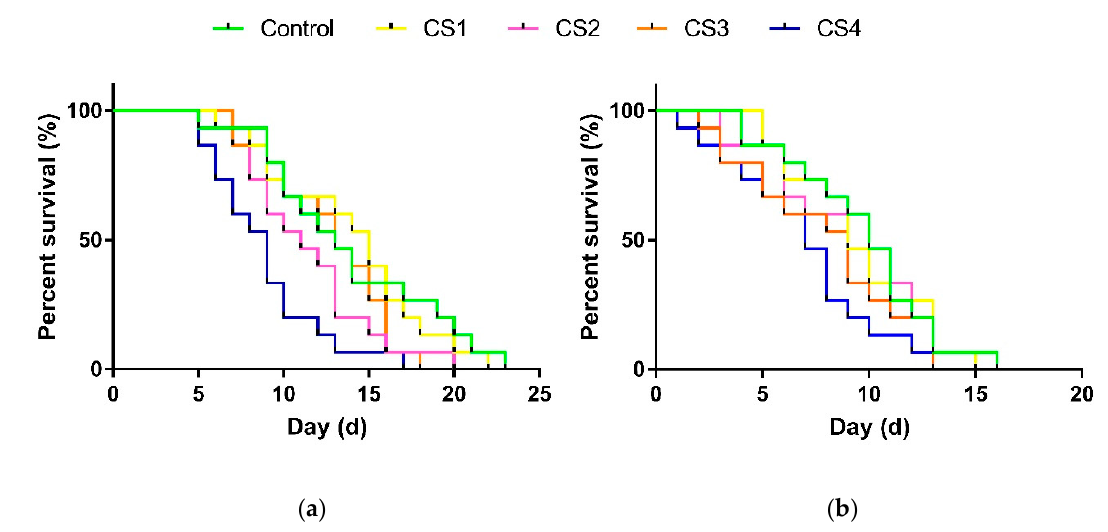
Figure 2. Survival curves of P. incisi post-storage female ( a ) and male ( b ) that had been subjected to different pupal cold storage treatments. CS1: cold storage 1, late-age pupae stored at 13 °C for 10 d; CS2: cold storage 2, middle-age pupae stored at 13 °C for 10 d; CS3: cold storage 3, late-age late pupae stored at 13 °C for 15 d; CS4: cold storage 4, middle-age pupae stored at 13 °C for 15 d. Control means P. incisi pupae developed at 25 °C ( n = 15). Table 4. Reproductive parameters of G1 P. incisi post-storage adults ( n = 15). Treatment Pre-Oviposition Period (d) Oviposition Period (d) Post-Oviposition Period (d)